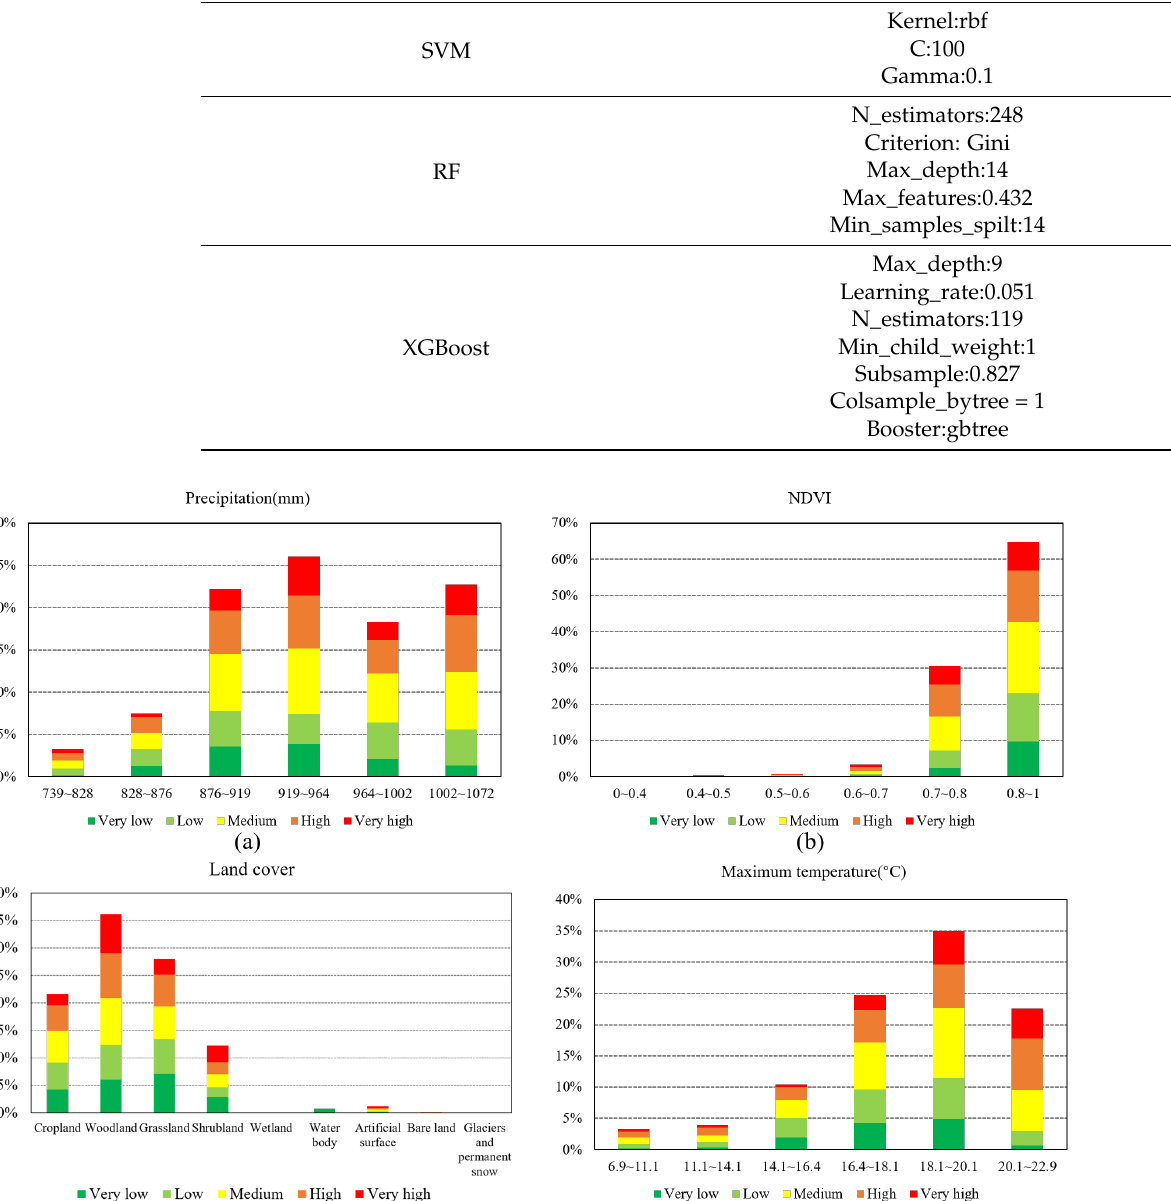
Table A3. Optimal parameters of the three models.